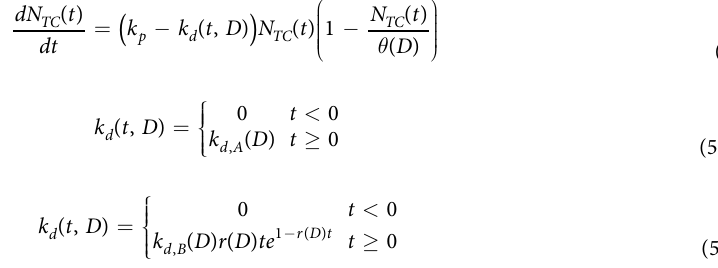
maximum number of cells that can be supported by the experimental system, and N TC ( t ) is the number of tumor cells at time t . Prior to treatment (i.e., t < 0), cells are modeled to have a constant proliferation rate, k p . Following